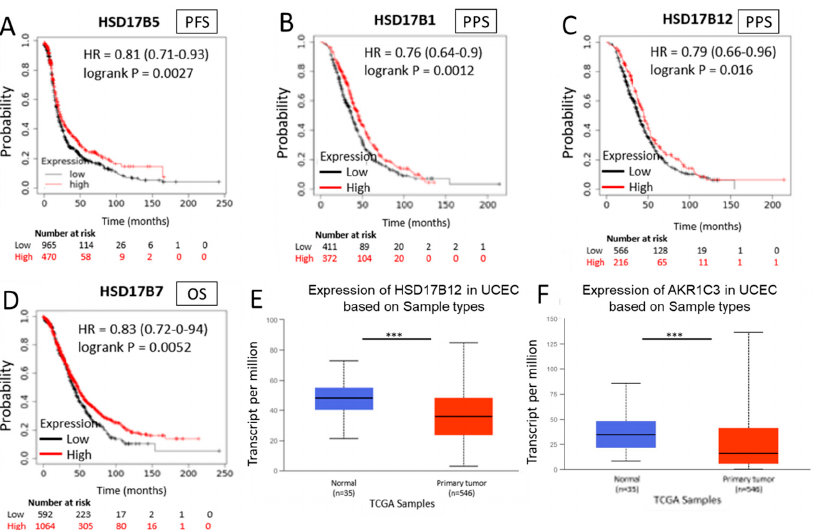
Figure 7. Expression of HSD17B enzymes involved in estradiol synthesis and ovarian cancer patient outcome ( A – D ) . Kaplan–Meier curves comparing low (black line) vs high (red line) tumour expression levels of different enzymes of the HSD17B family; HSD17B5 enzyme in PFS ( A ); HSD17B1 enzyme in PPS ( B ); HSD17B12 enzyme in PPS ( C ); HSD17B7 enzyme in OS ( D ). Expression of HSD17B12 in normal and tumour samples taken from the TCGA program ( E ). Expression of AKR1C3 in normal and tumour samples taken from the TCGA program ( F ). *** p < 0.001. In addition, the analysis of “The Cancer Genome Atlas” (TCGA) database shows a lower expression of the E2-synthetizing enzymes HSD17B12 and HSD17B5 (also called AKR1C3) in tumour tissue samples compared to normal tissues for UCEC (Figure 7E,F).